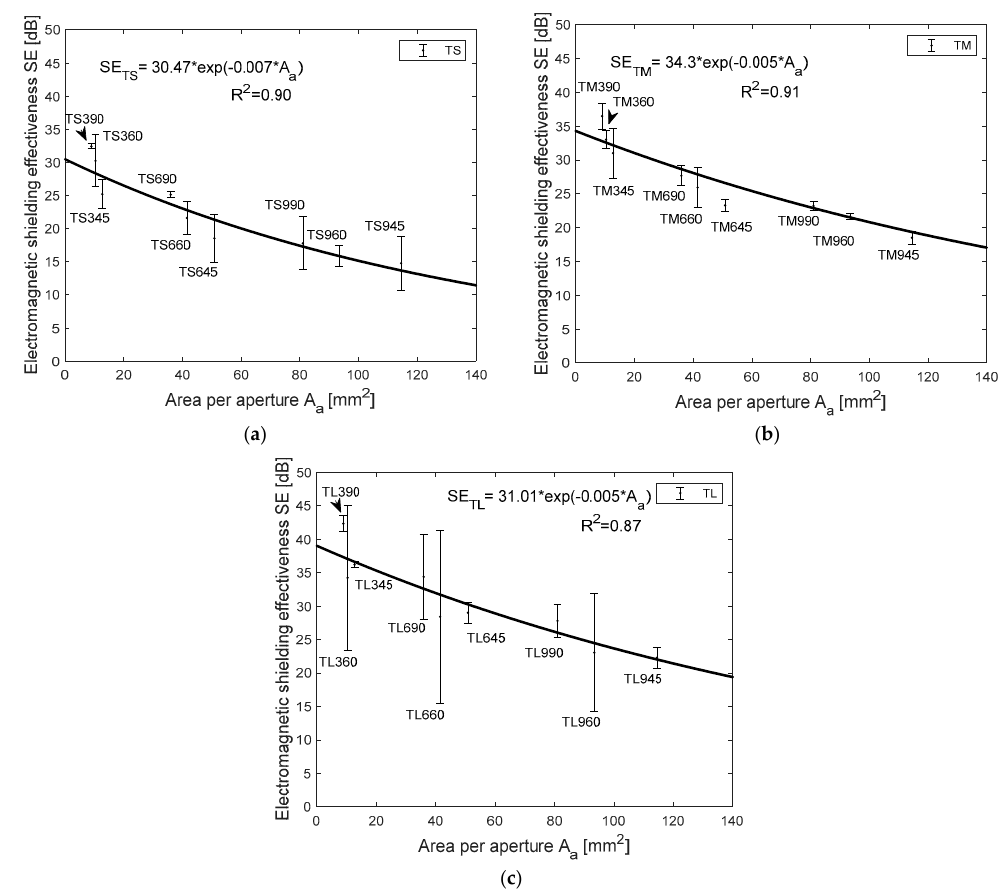
Figure 7. Graph of shielding effectiveness (SE) (dB) at 1.5 GHz frequency versus area per aperture (A a ) (mm 2 ), two-layer strips of ( a ) 3 mm thickness samples, ( b ) 6 mm thickness samples, and ( c ) 9 mm thickness samples.